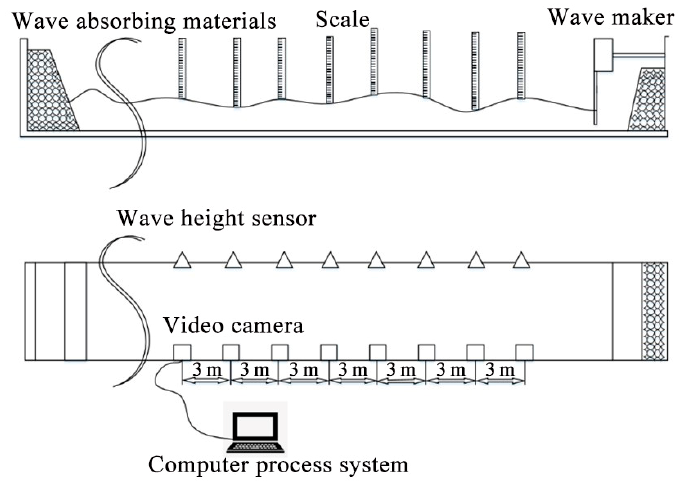
Figure 2. Experiment layout. Table 1. Experimental working condition parameter